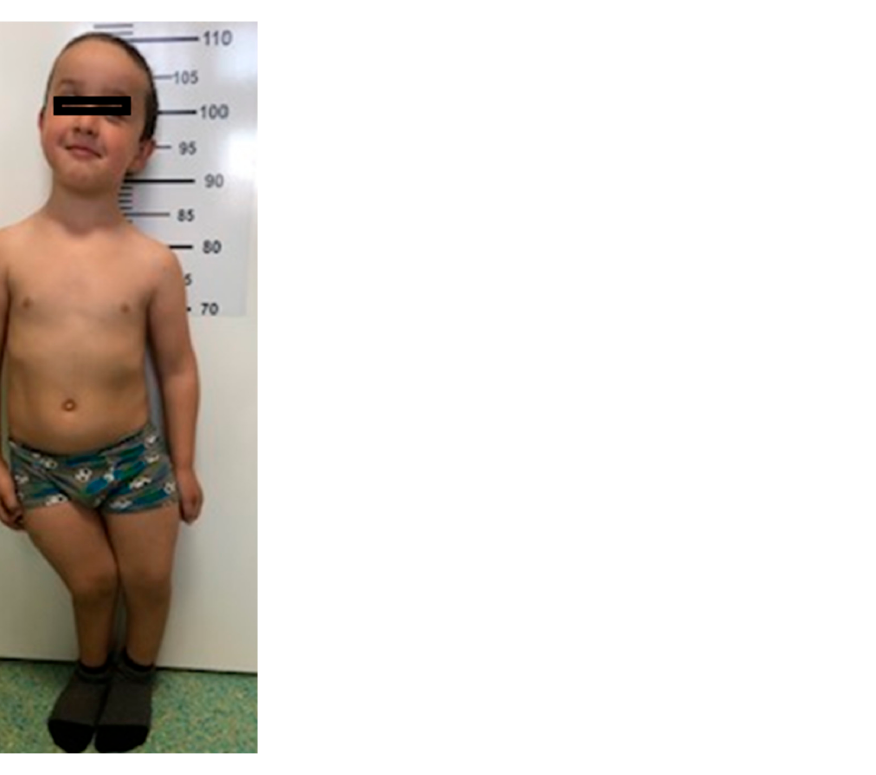
Figure 2. Case #2. Brother at 7 years old: short stature, macrocephaly, genu valgum deformation of lower limbs, knees touching each other while ankles remain spaced